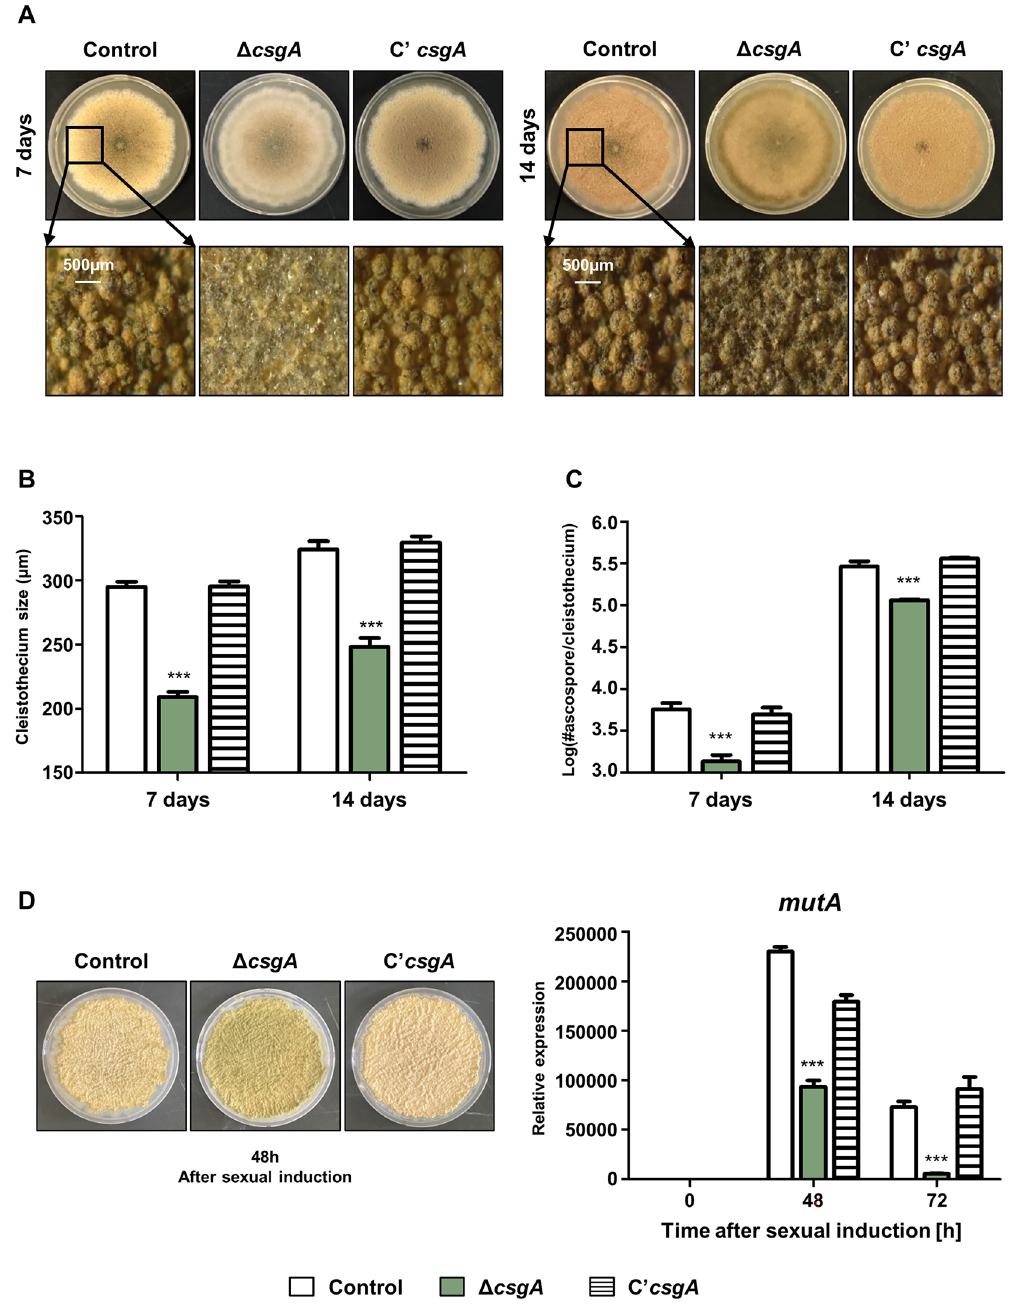
Figure 3. The roles of csgA in sexual development. ( A ) Colony photographs of control (TNJ36), Δ csgA (THJ13.1), and C’ csgA (THJ28.1) strains point-inoculated on solid SM and grown for 7 days and 14 days at 37 °C in dark condition. ( B ) Sizes of a single cleistothecium from each strain shown in ( A ). ( C ) Germination of ascospores from each strain. ( D ) Left, colony photographs of each strain at 48 h after sexual induction. Right, qRT-PCR analyses of mutA expression in each strain. *** p <